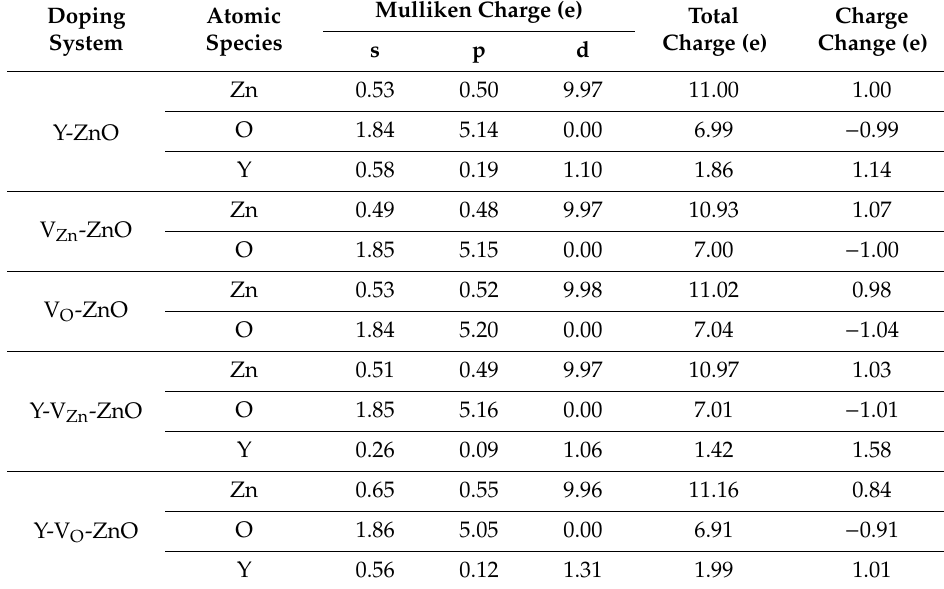
Table 2. The atomic populations (Mulliken charge) of ZnO ML with Y, vacancy (V Zn , V O ), and ZnO ML with Y and vacancy (V Zn , V O ).